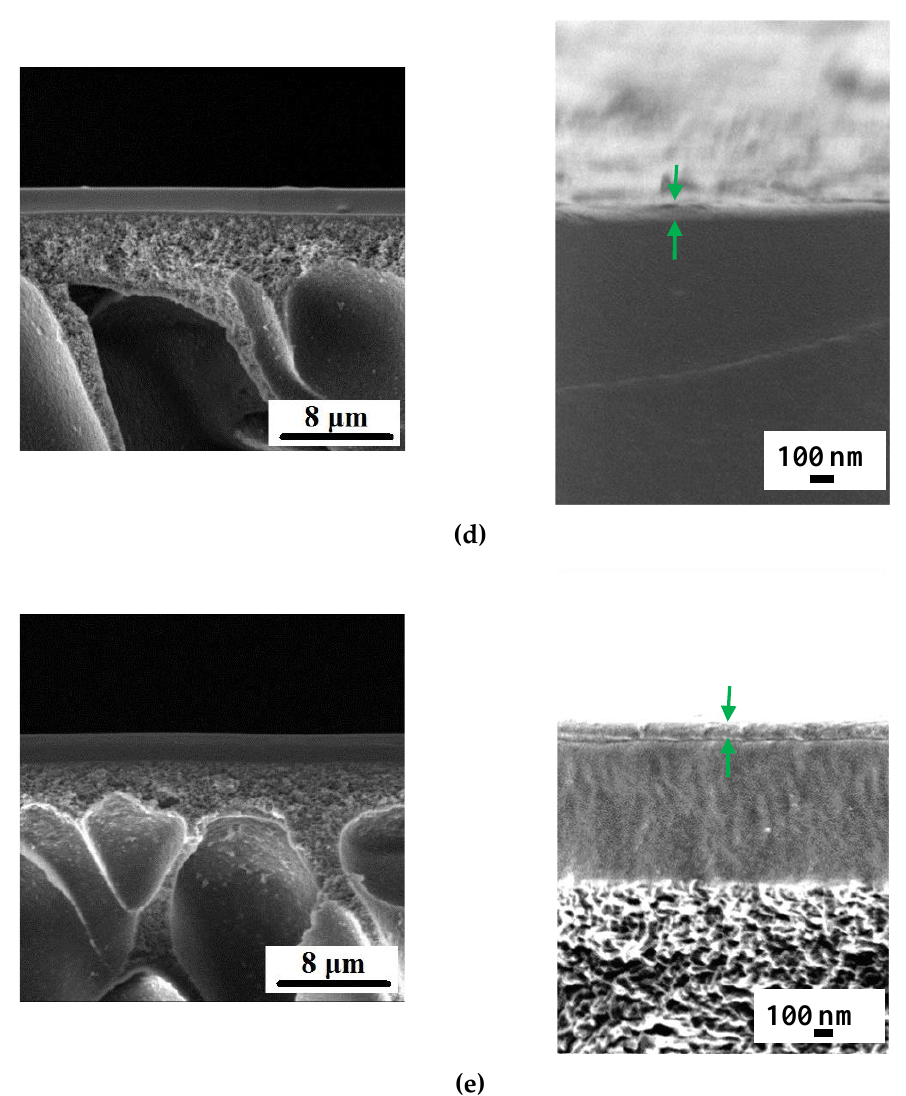
Figure 2. SEM micrographs of the cross-section of the selective layers of TFC and TFN membranes at higher and lower magnifications: ( a ) D30; ( b ) D30-IP; ( c ) D30-IP1; ( d ) D30-IP3; ( e ) D30-IP5. The arrows show the PA selective layer prepared via IP.